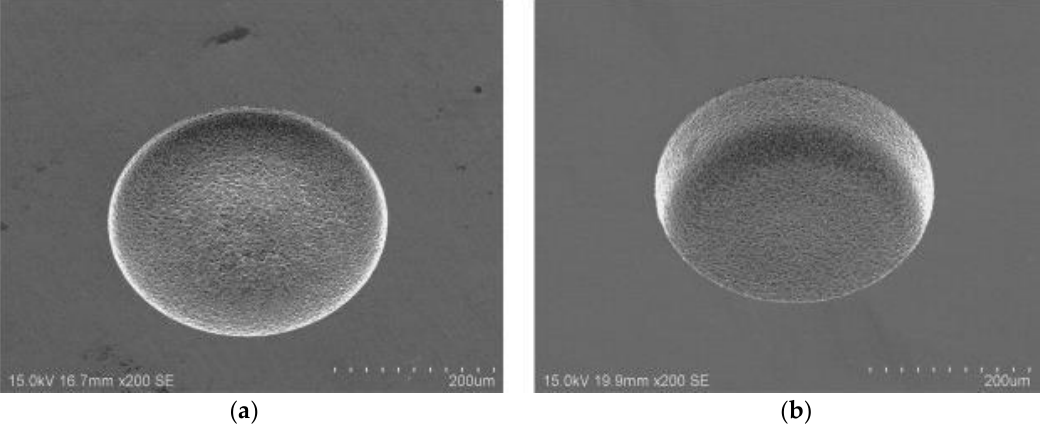
Figure 15. SEM micrographs of micro-holes after machining time of 2 min with ultrasonic cavitation in ( a ) pure EDM oil and ( b ) carbon nanofibers mixed EDM oil. (Reproduced with permission from [111]).